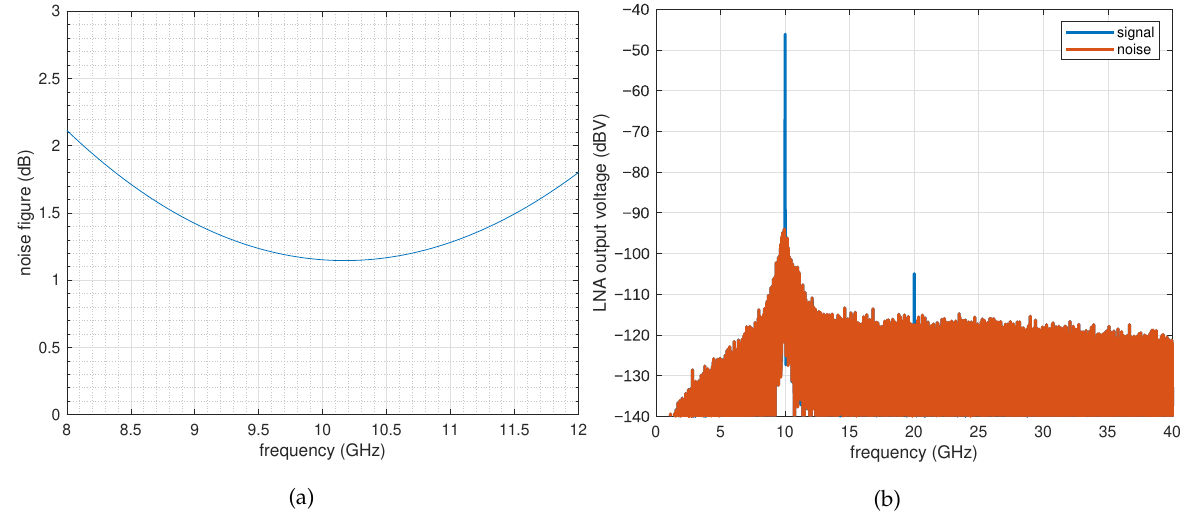
Figure 12. Simulations of the LNA noise figure ( a ) and output voltage spectrum ( b ), computed using a 2 20 -points FFT over a 819.2 ns long signal window with the antenna feeding 5µA ( − 62dBm) of current into the LNA. The output voltage fundamental results in − 46.1dBV ( − 36.1dBm), corresponding to √ an effective gain of 25.9dB. The noise floor is − 160dBm/